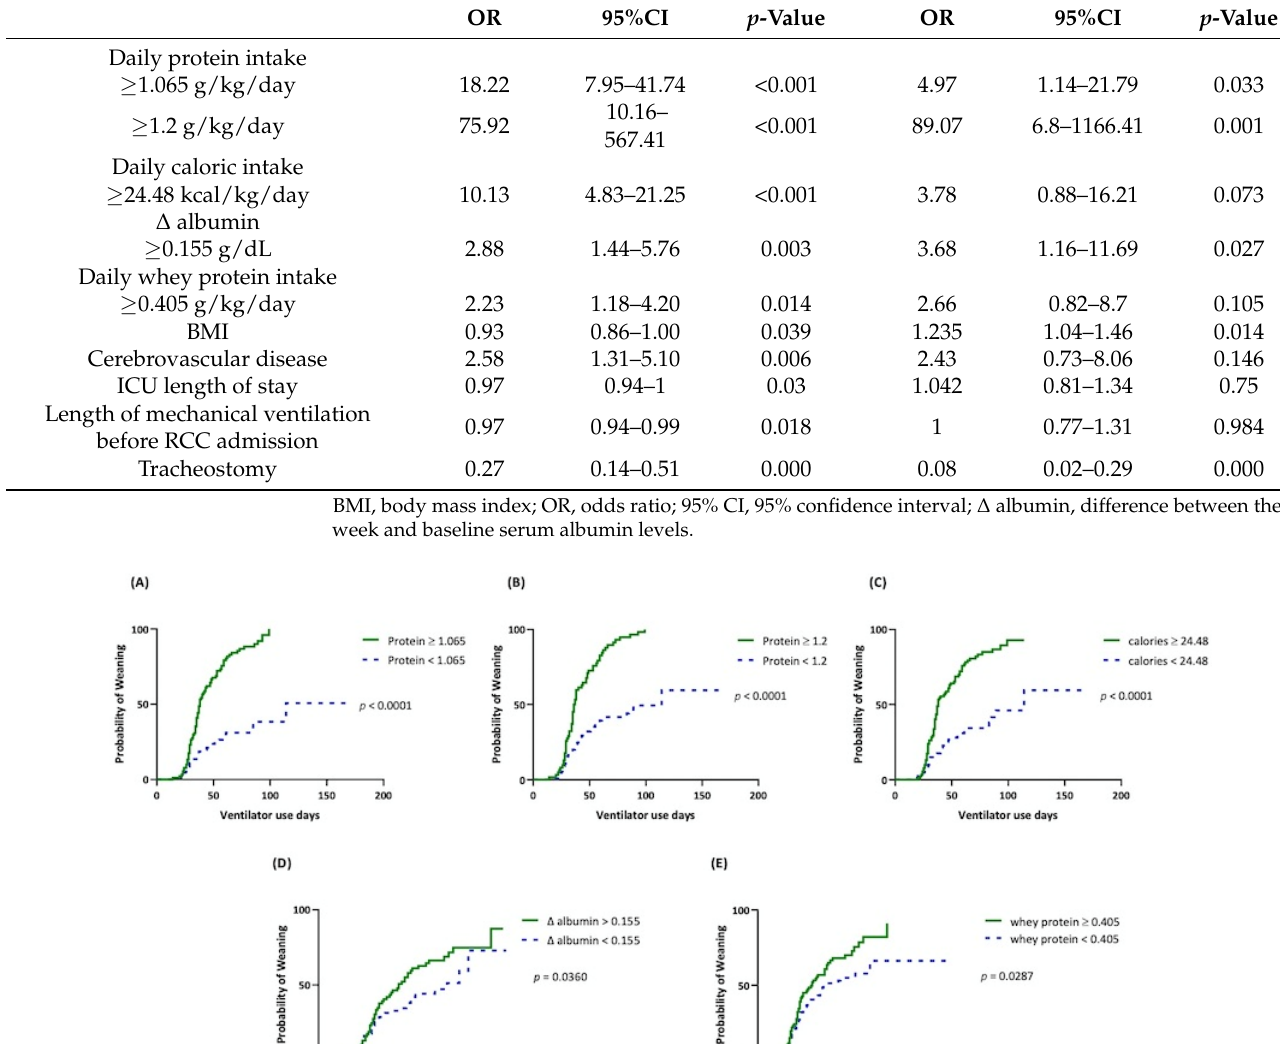
Table 2. Factors associated with weaning outcomes.